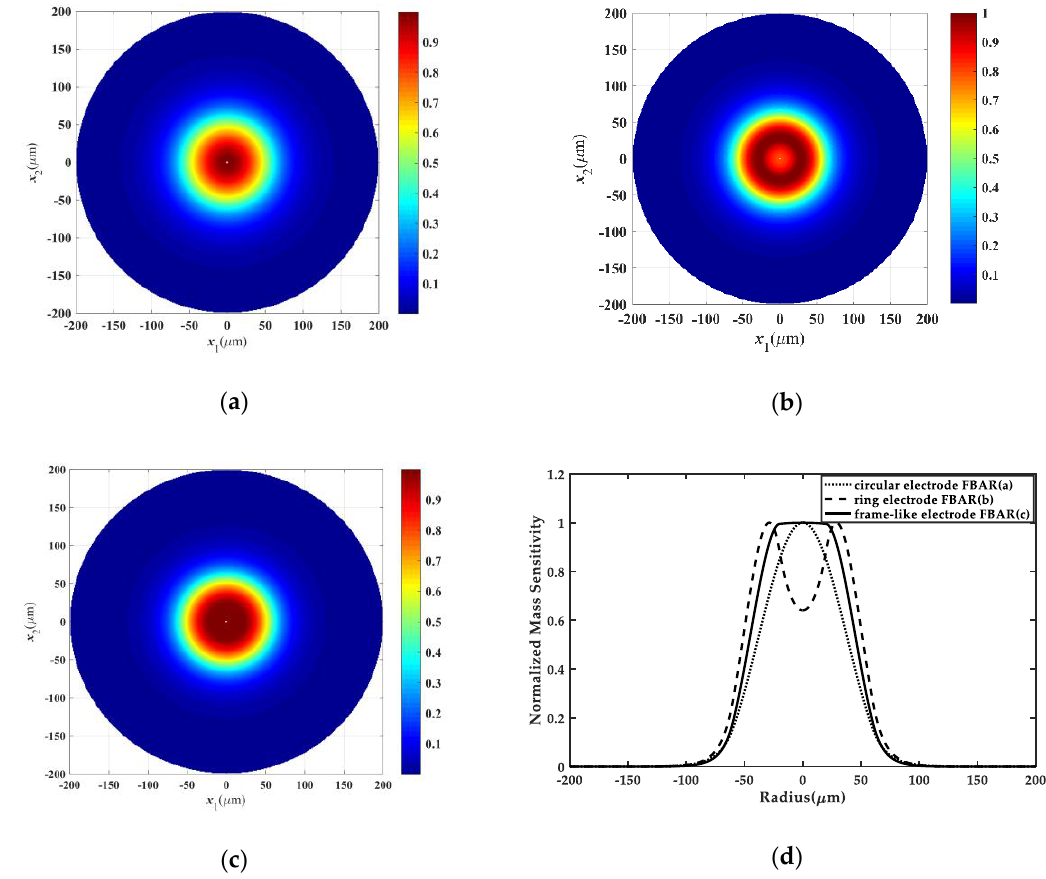
Figure 2. 2D top view of the fundamental thickness-extensional (TE) mode in the normal circular electrode (energy-trapped) FBAR sensor ( a ), the ring electrode FBAR sensor ( b ), and the frame-like electrode FBAR sensor ( c ). Normalized mass sensitivity distributions of these three cases can be seen in ( d ).